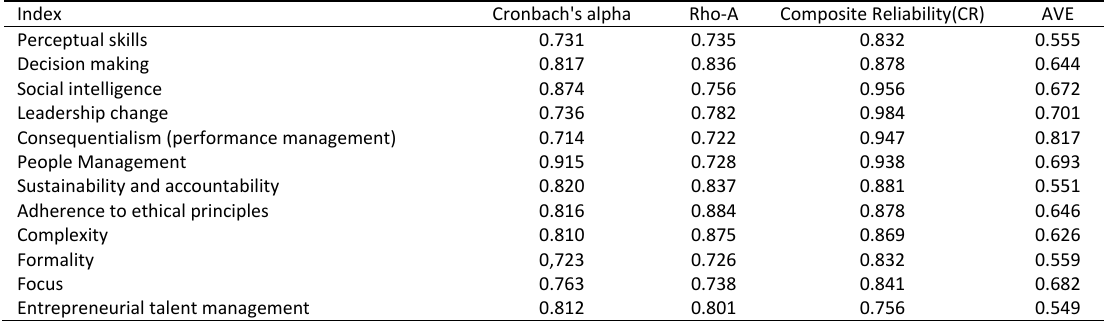
Table 1: Cronbach's Alpha, Combined Reliability and Average Variance Extracted (AVE) Table 1: Cronbach’s Alpha, Combined Reliability and Average Variance Extracted